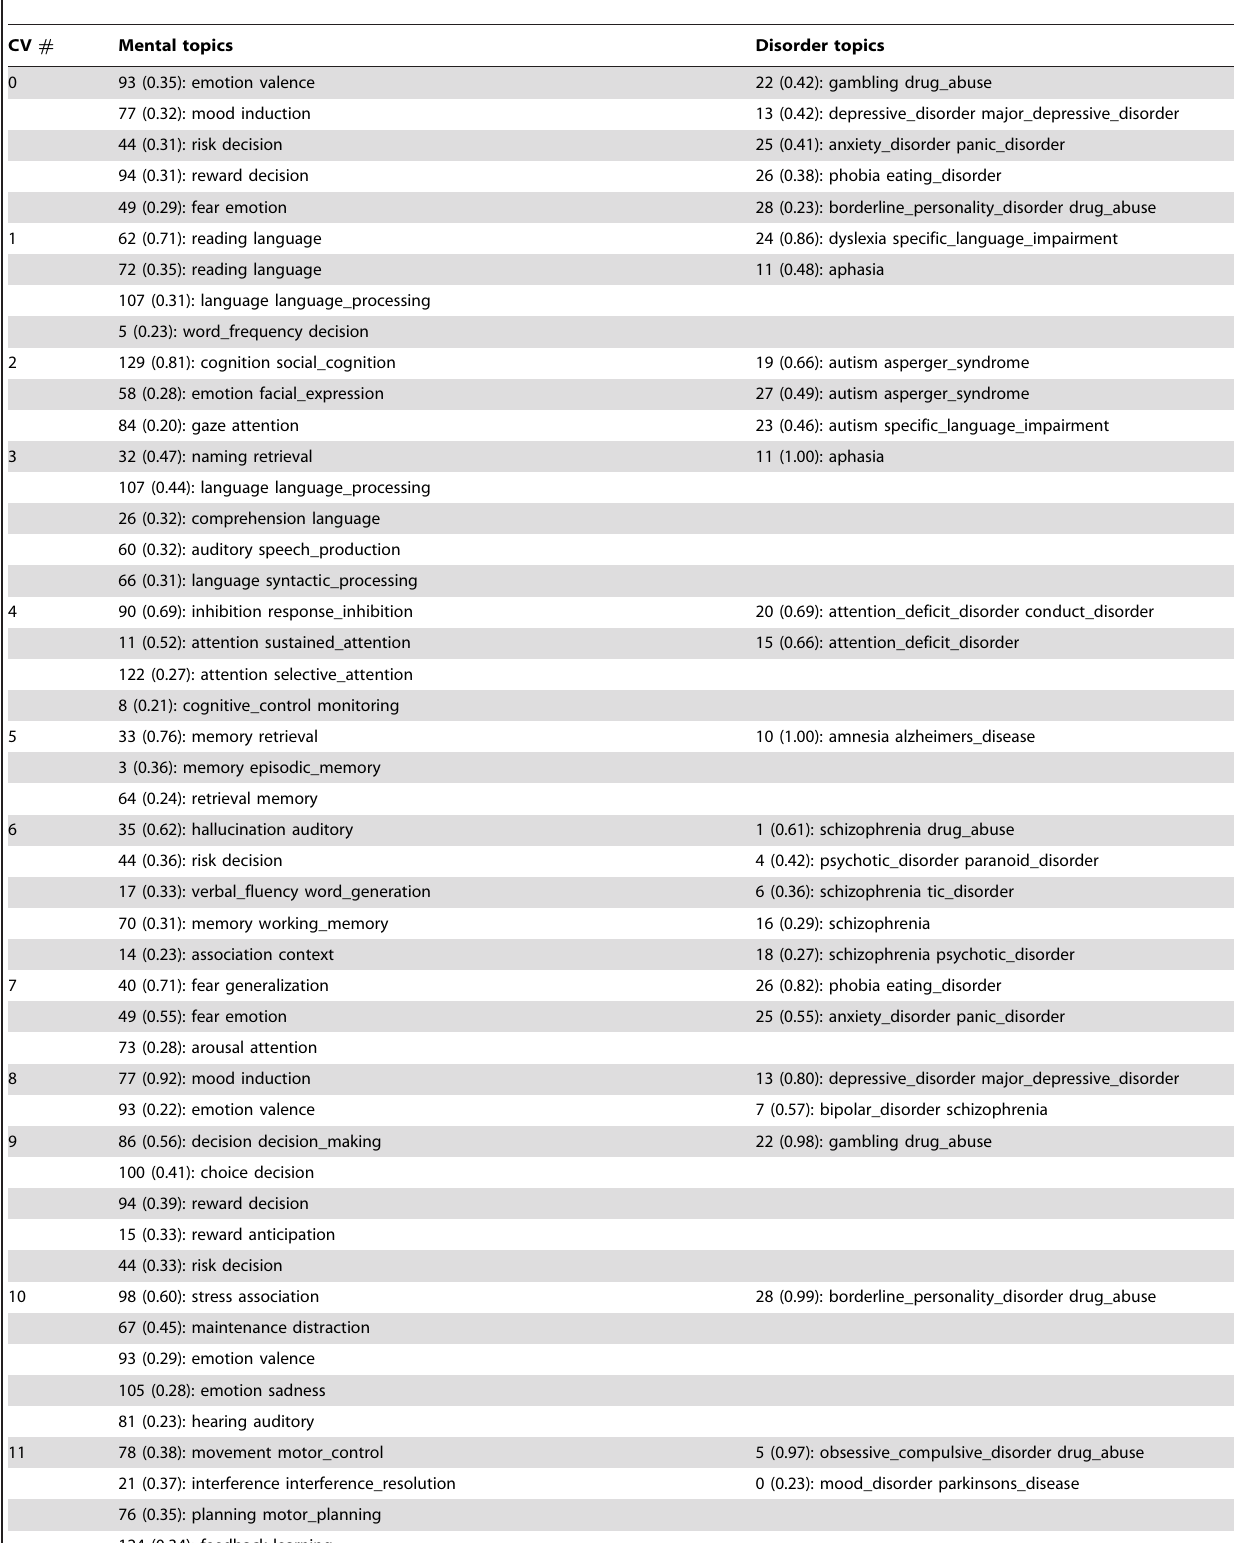
Table 2. Canonical variates obtained using sparse canonical correlation analysis directly on document/topic loading distributions for cognitive and disorder